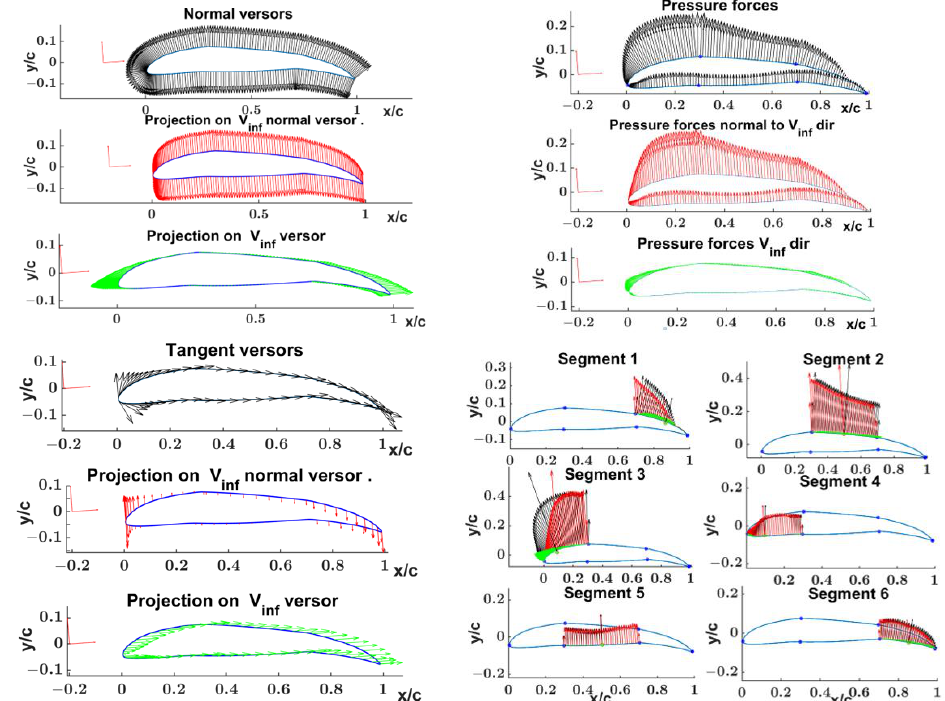
Figure 31. Morphed NACA 23012 normal & tangent vectors projection along the V inf direction, and the normal to V inf , segments-wise contribution of pressure forces along the V inf and the normal to it. Figure 32 shows the segment distribution of the friction forces, their resultants, and their decomposition along the V inf direction and its normal. forces.